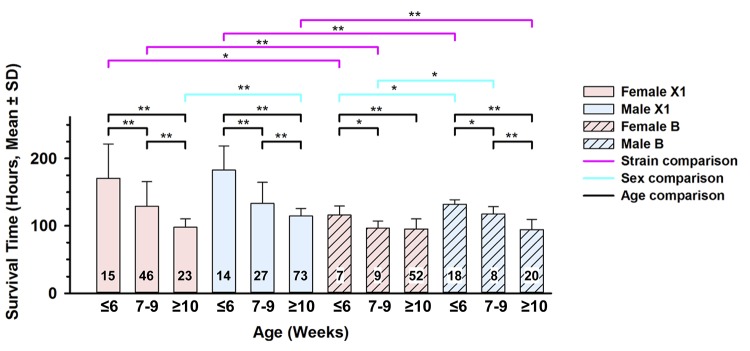
Survival time comparisons of X1 and B controls stratified by age and sex.Survival times for all exposed mice (6–12 weeks old) of each progenitor strain were combined and sorted by sex into three distinct age groups: ≤ 6 weeks old, 7–9 weeks old, and ≥ 10 weeks old at the initiation of exposure. Resistant X1 control mice (solid bars) are displayed at the left half of the figure, with sensitive B control mice (striped bars) shown at the right half. The number of mice tested in each group is given at the base of each bar plot. For direct within-strain sex comparisons, females (pink bars) and males (blue bars) are positioned side-by-side. Comparisons were also made between age groups (females or males) and between strains for the same age group, with Bonferroni corrections for multiple testing. *, p < 0.05; **, p < 0.001.